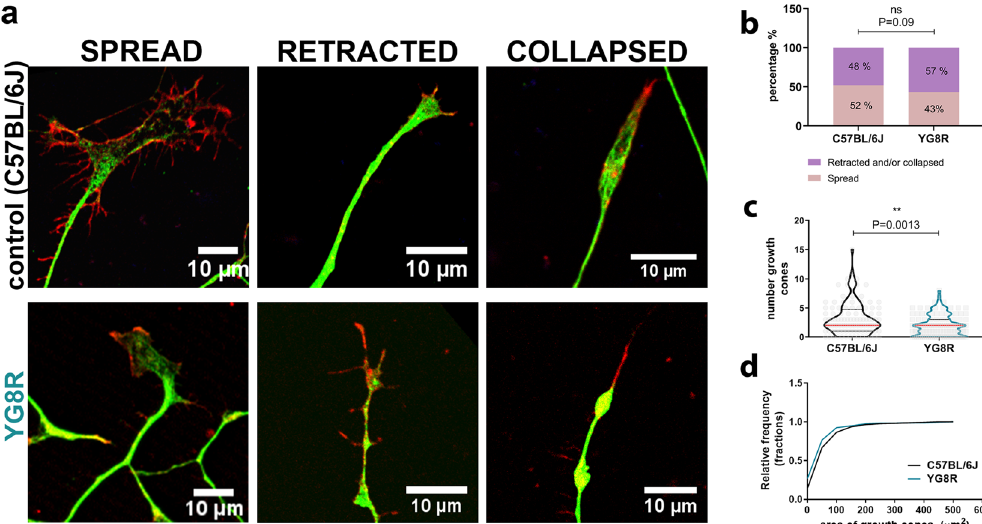
Figure 1. Growth cones of frataxin-deficient neurons exhibit morphological alterations. ( a ) Representative images of different types of growth cones of YG8R (lower panel) and control mice (C57BL/6J) (upper panel). Growth cones were visually classified as spread or collapsed/retracted according to characteristic β -tubulin-III (green) and F-actin (red) distribution. ( b ) Distribution of the growth cones in the spread or collapsed/retracted between both genotypes. Differences between genotypes were assessed using Chi-square test: P = 0.09. ( c ) Sensory neurons from YG8R mice exhibited fewer growth cones per neuron compared to controls. The data distribution is presented with violin plots. Data (grey dots), the median (red horizontal lines) and interquartile (black horizontal lines) are shown. Mann-Whitney test was used to analyse significant changes between genotypes: ** P = 0.0013. ( d ) Cumulative distribution of the growth cone area was plotted for both genotypes. Most of the growth cones from YG8R mice were smaller (0–100 µ m 2 ) than those from the controls. Mann- Whitney test was used to analyse significant changes between genotypes: ** P =